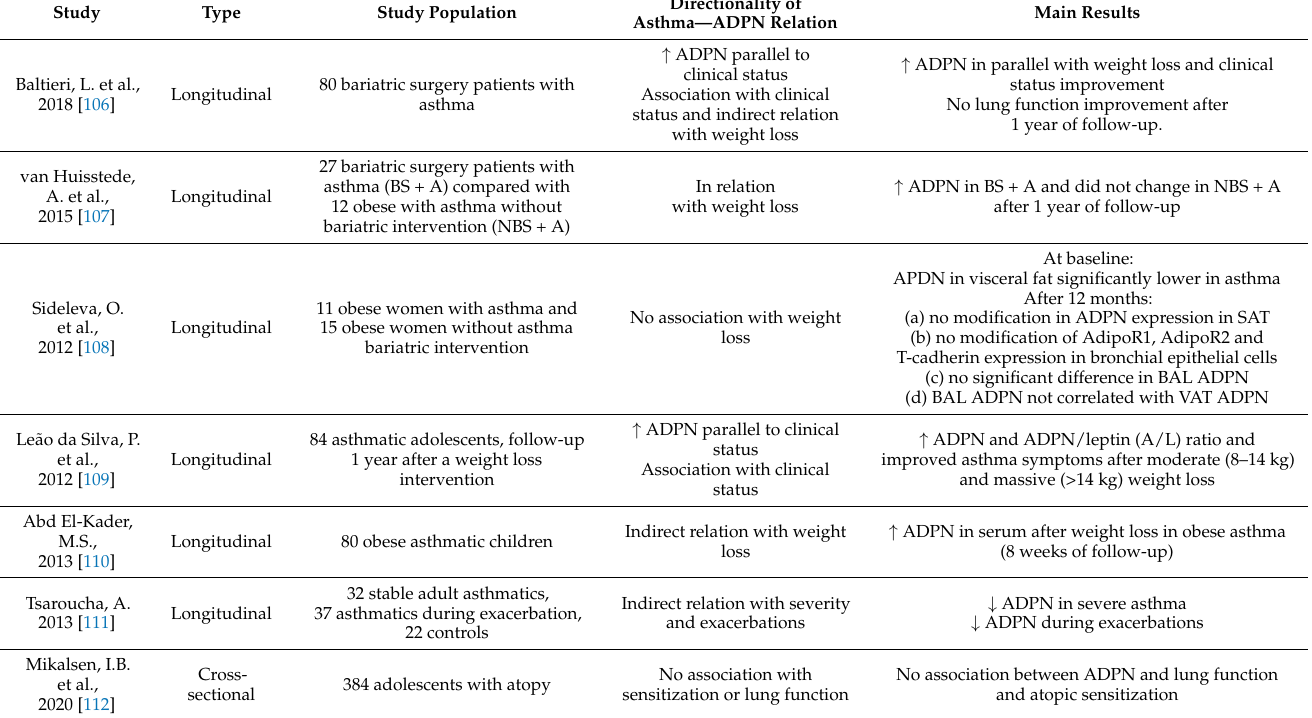
Table 1. Association of adiponectin and asthma in epidemiological